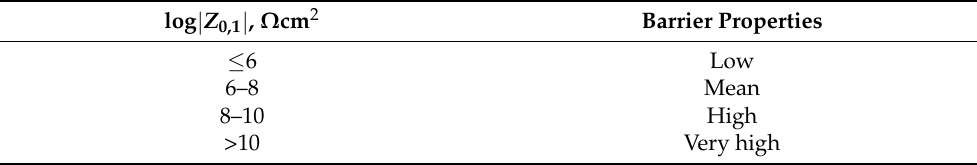
Table 1. Criteria for evaluating the barrier properties of paint coatings on steel elements based on